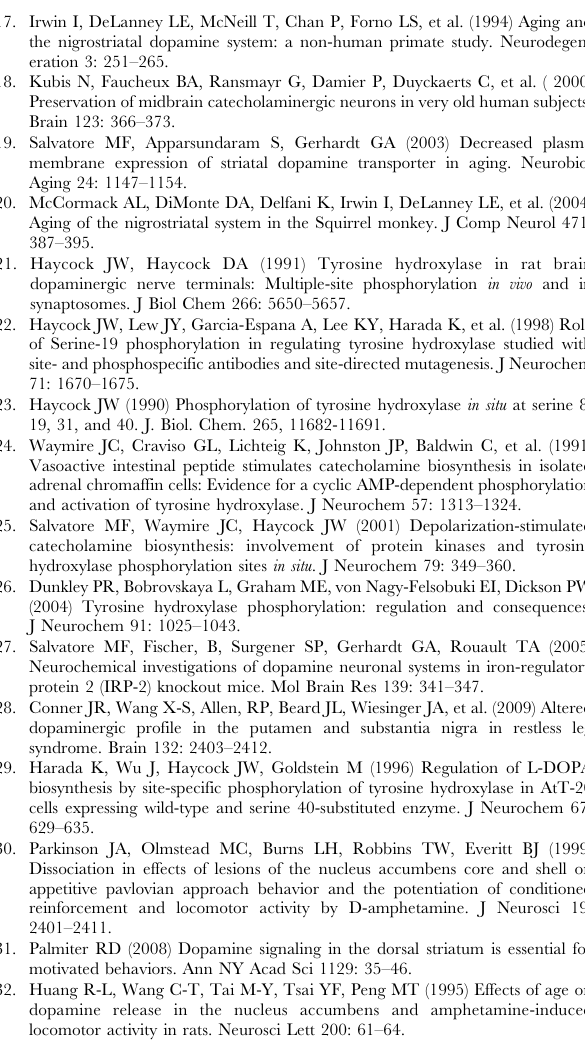
Figure S5 Example of between-group differences and session-to- session variability total distance and movement number in two selected pairs of young and old test subjects. Test results are from the 12 and 30 month session. In young-1 vs. old-1, no difference in mean locomotor activity was seen in spite of the age difference, whereas in young-2 vs. old-2 a significant difference in mean